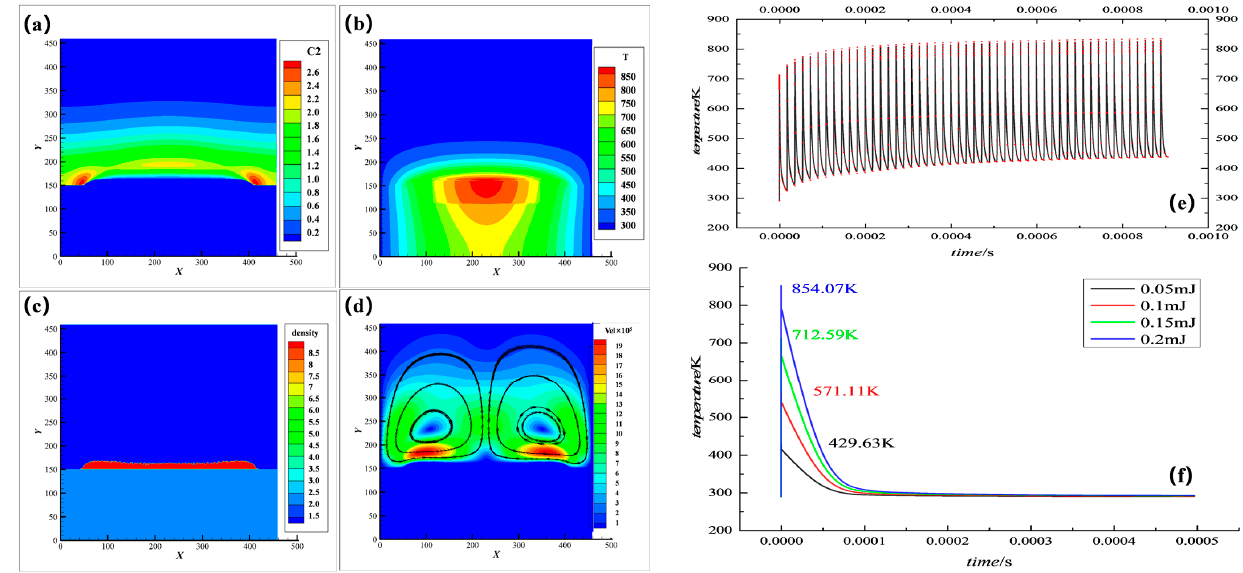
Figure 3. Laser-induced coupling of multiple physical fields. ( a ) C(aq) concentration distribution; ( b ) Temperature distribution cloud map; ( c ) Sediment topography; ( d ) Flow field and streamline diagram; ( e ) Temperature change curve with time; ( f ) Temperature change curve under single pulse of different laser conditions.